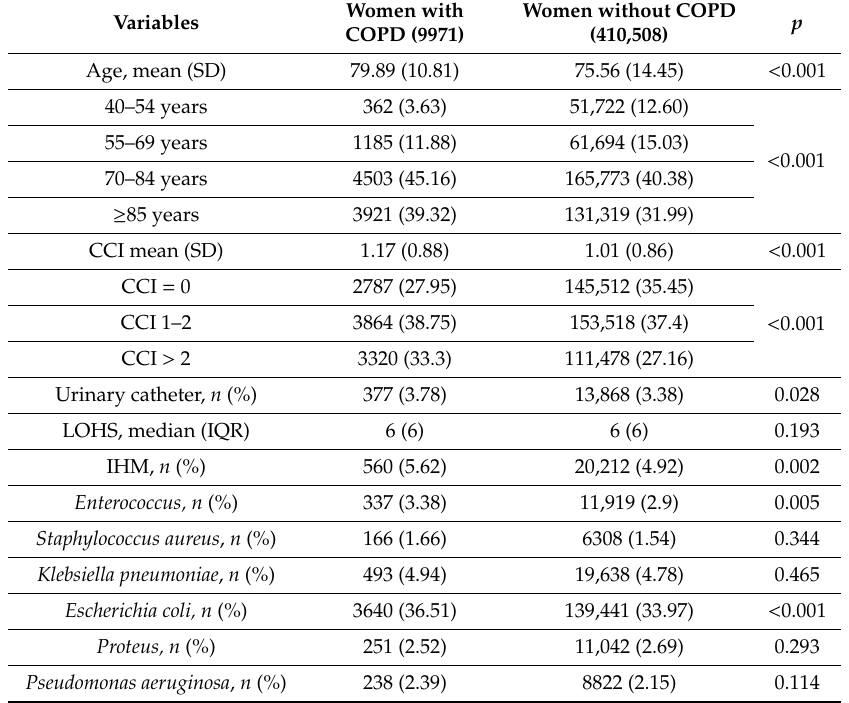
Table 2. Age distribution, comorbidities, procedures, in-hospital outcomes and isolated pathogens among men hospitalized with a principal diagnosis of urinary tract infection in Spain, 2001–2018, according to COPD